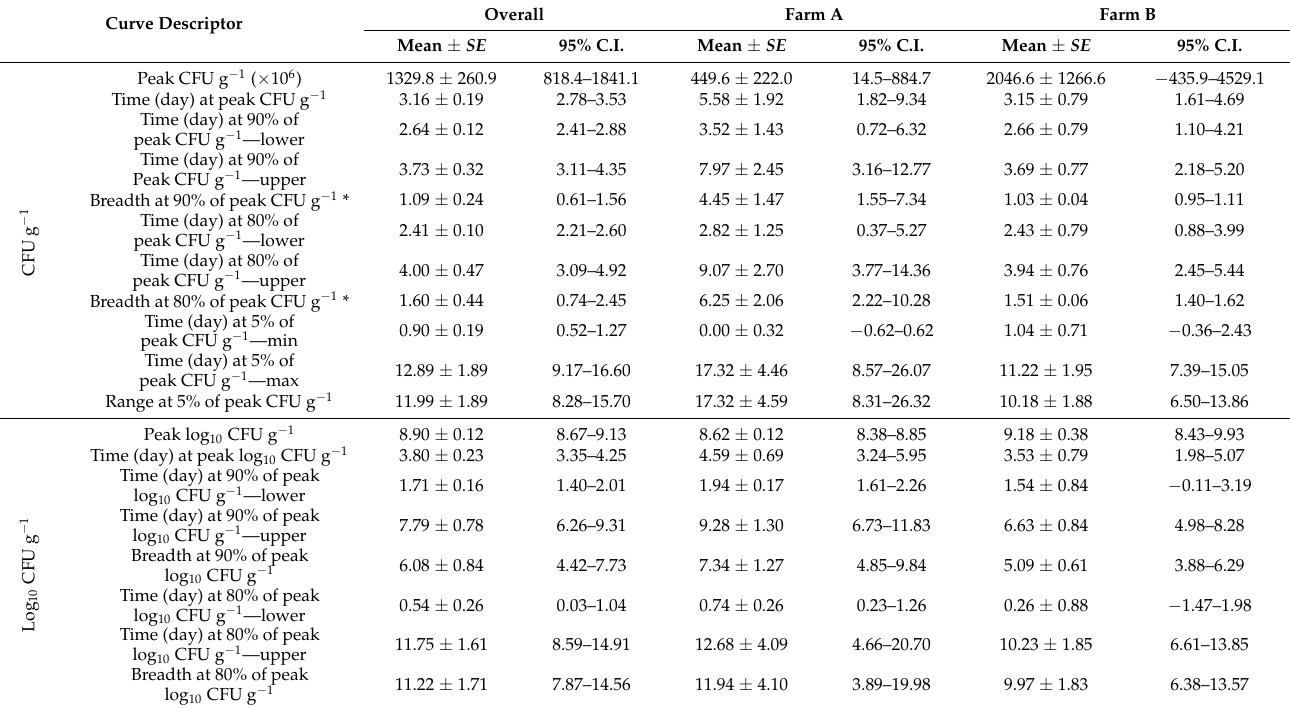
Figure 6. Relationship between virulent Aeromonas hydrophilia population in soil (CFU g −1 : ( A – C ); log 10 CFU g −1 : ( D – F )) and time (days) using a smoothing spline (SS) model and 95% confidence intervals (gray shadow). Left figures ( A , D ) represent all samples; middle figures ( B , E ) represent farm A; right figures ( C , F ) represent Farm B. Estimates of SS model descriptors are summarized in Table 1. Table 1. Mean, standard error ( SE ), and 95% confidence intervals (CI) for descriptors of smoothing spline models presented in Figure 5. Statistical differences in endpoints between farm soil are denoted with an asterisk (*).